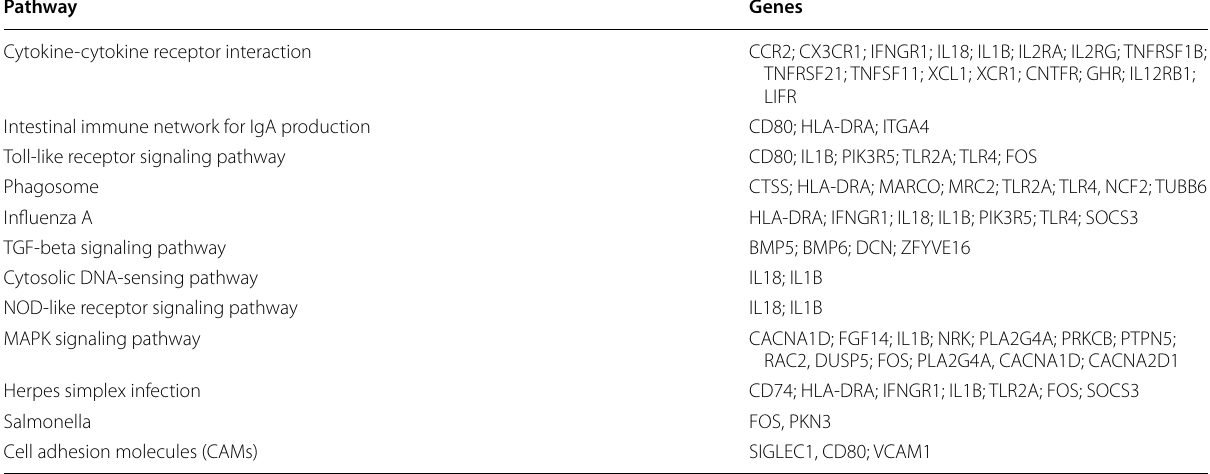
Table 2 Regulatory pathways and gene modifications by Lactobacillus johnsonii BS15 decreased liver inflammation